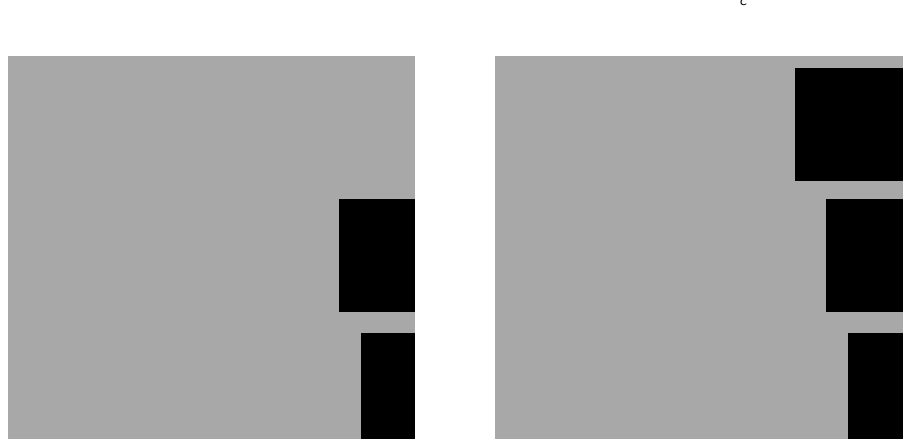
T . Figure 7. Masks under different T c c